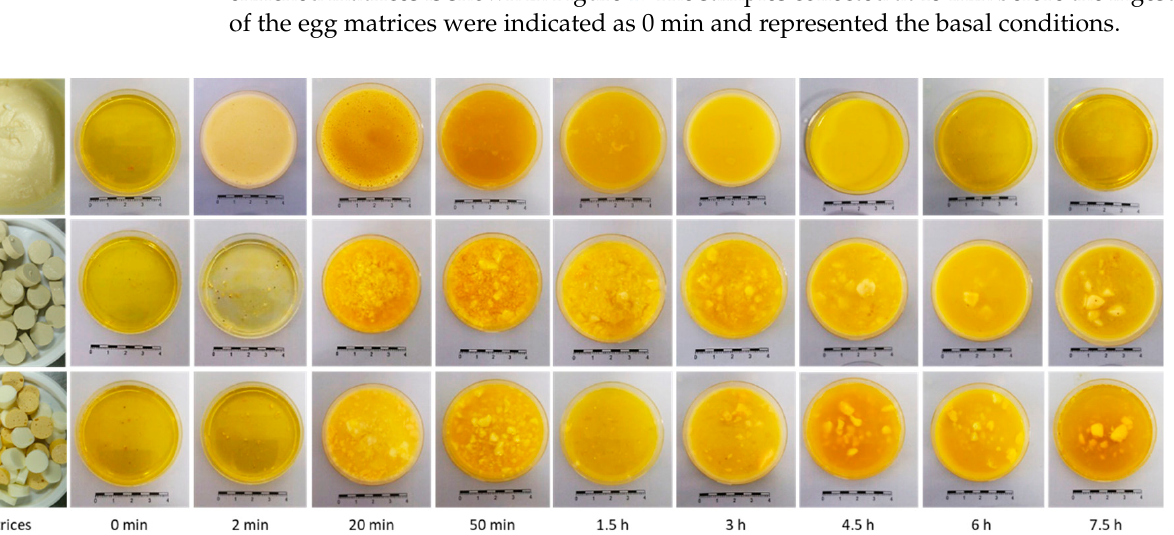
Means and SEM were calculated from n = 3 measurements for omelet and mousse, n = 2 measurements for hard-boiled egg.